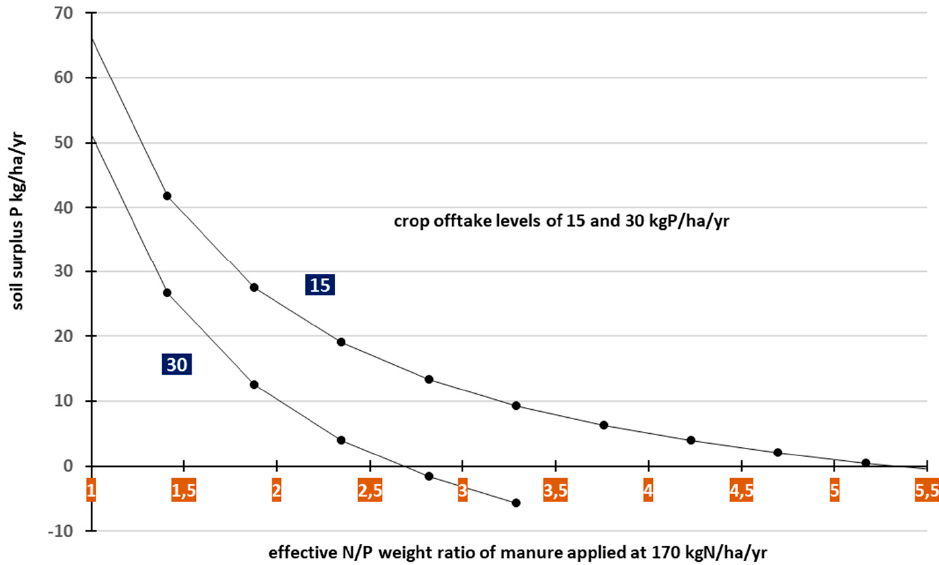
Figure 9. Graphic showing the relationship between the effective N/P ratio of manure applied at 170 kgN/ha/year (maximum standard for Nitrate Vulnerable Zones, EU Nitrates Directive) and the resulting soil P surplus for crops at offtake levels of 15 and 30 kgP/ha/year. A minus surplus represents “mining” of the P reserves in the soil.